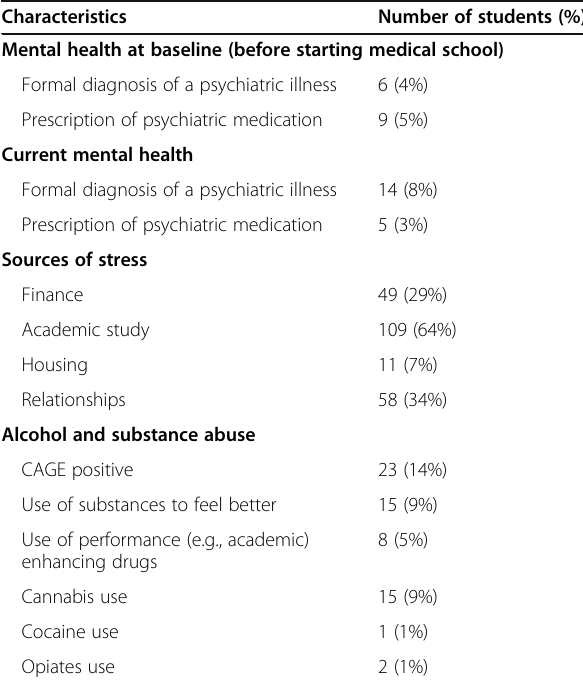
Table 2 Health characteristics of our respondents